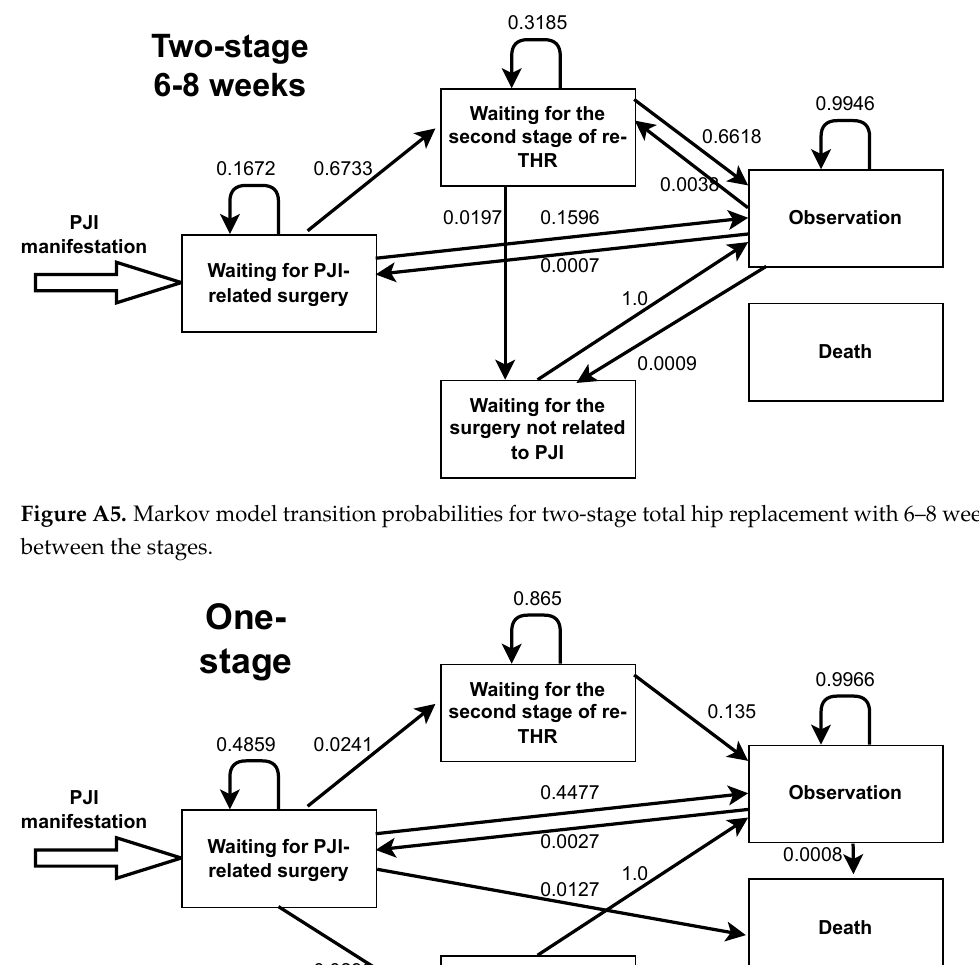
Figure A4. Markov model transition probabilities for two-stage total hip replacement with 2–3 weeks between the stages.